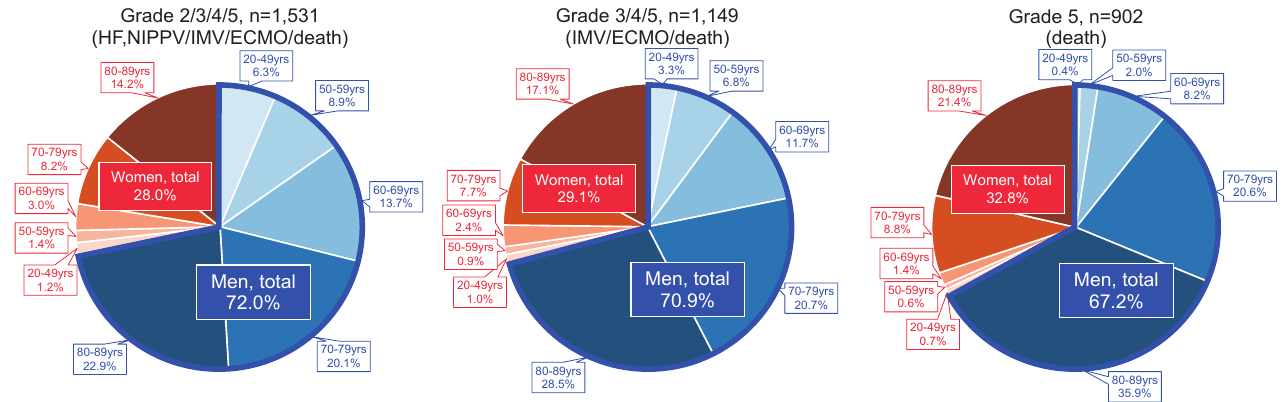
Figure 3. Proportion of sex and age groups among moderate to severe disease grades or death in COVID-19 patients registered in Japan. ECMO, extracorporeal membrane oxygenation; HF, high- fl ow oxygen devices; IMV, invasive mechanical ventilation; NIPPV, non-invasive positive pressure ventilation.